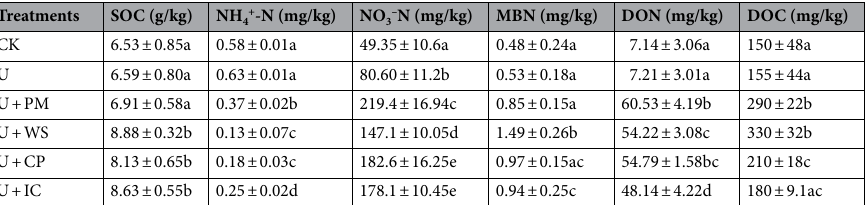
Table 1. Soil properties in different treatments with OAs. CK no urea and OAs, U urea, U + WS urea plus wheat straw, U + PM urea plus pig manure, U + CP urea plus compost, U + IC urea plus improved compost. Values are mean ± standard deviation (n = 3). The different letters indicate significant differences at the 0.05 probability level.